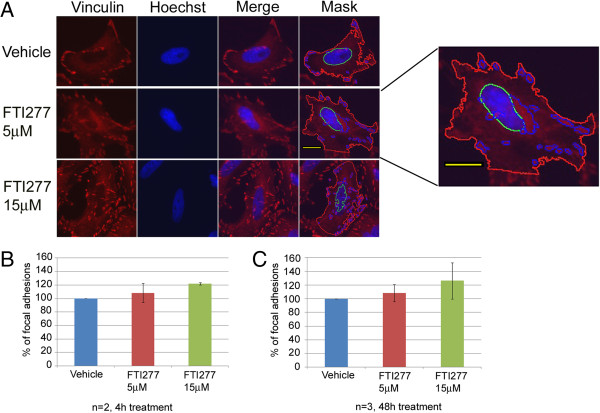
FTI-277 treatment of HeLa cells increases focal adhesions. A: The images show the localization of vinculin in FTI277-treated and vehicle-treated samples together with the software mask to identify total vinculin (red) and vinculin at the focal adhesions (blue). HeLa cells were treated as indicated in the text and stained for immunofluorescence analysis with α-vinculin primary and appropriate secondary fluorescently labeled antibody, as indicated in Methods. To calculate the number of focal adhesions in each experiment at least 86 cells were counted per sample. The software mask corresponding to the vinculin signal is highlighted (panel A, Mask, blue circled spots). The number of focal adhesions present in each sample was counted and normalized against the total number of cells counted. The number of focal adhesions in vehicle samples was arbitrarily considered 100%. The yellow scale bar represents 10 μM. B and C. The graphs show the mean ± SD of at least 2 independent experiments, each run in triplicate (three wells per condition) at the indicated time points.